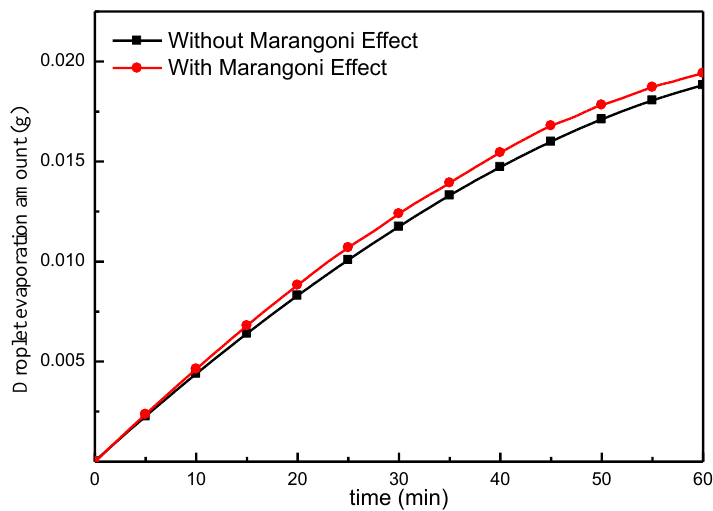
Figure 10. Effect of the presence or absence of Marangoni benefits on evaporation quality.